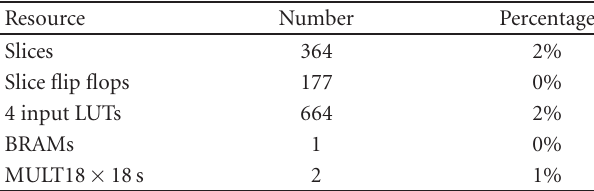
Table 4: Resource utilization